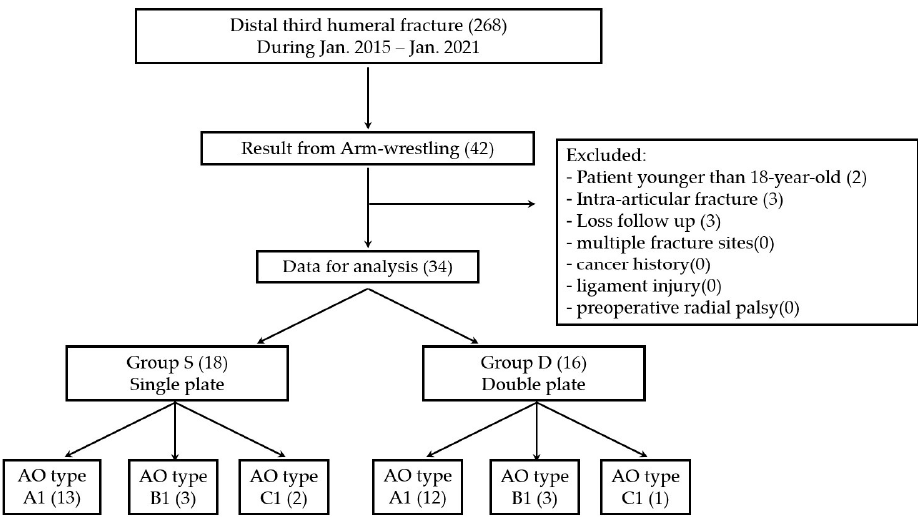
Figure 1. Participants flow. AO = Arbeitsgemeinschaftfür Osteosynthesefragen.